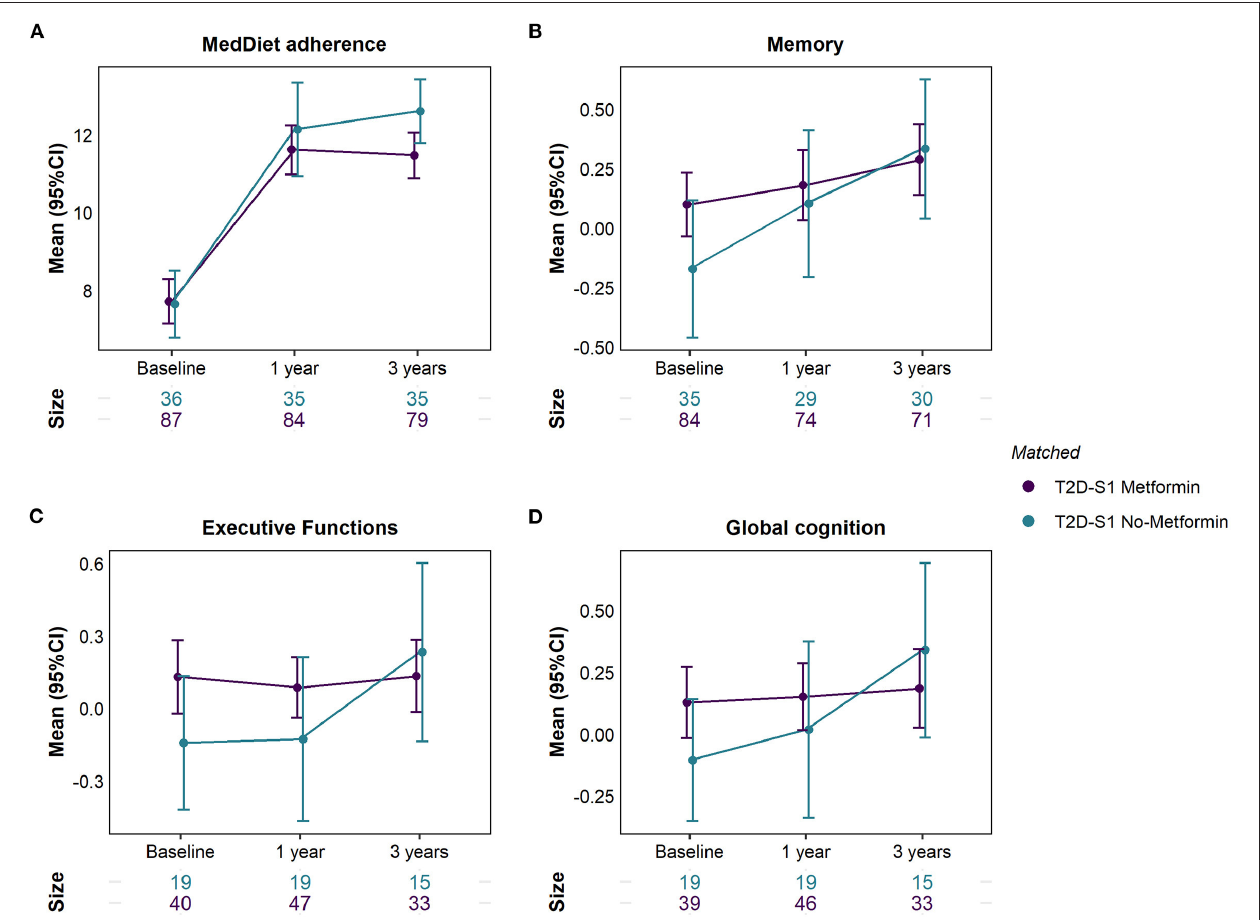
FIGURE 3 | Differences in (A) MedDiet adherence, (B) Memory, (C) Executive functions, and (D) Global cognition between participants with type 2 diabetes from subgroup 1 (T2D-S1) treated and not treated with metformin (individuals were matched with inverse probability of treatment weights).